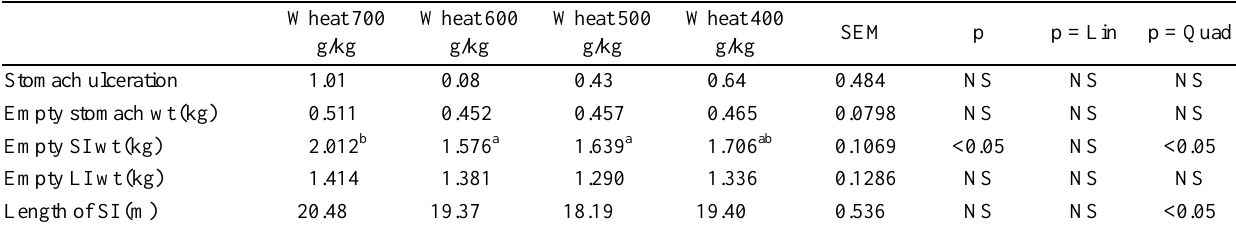
Table 4. The effect of dietary inclusion level of wheat on stomach ulceration, weight of empty stomach and empty large intestine (LI) and weight and length of empty small intestines (SI) (LWT applied as covariate)